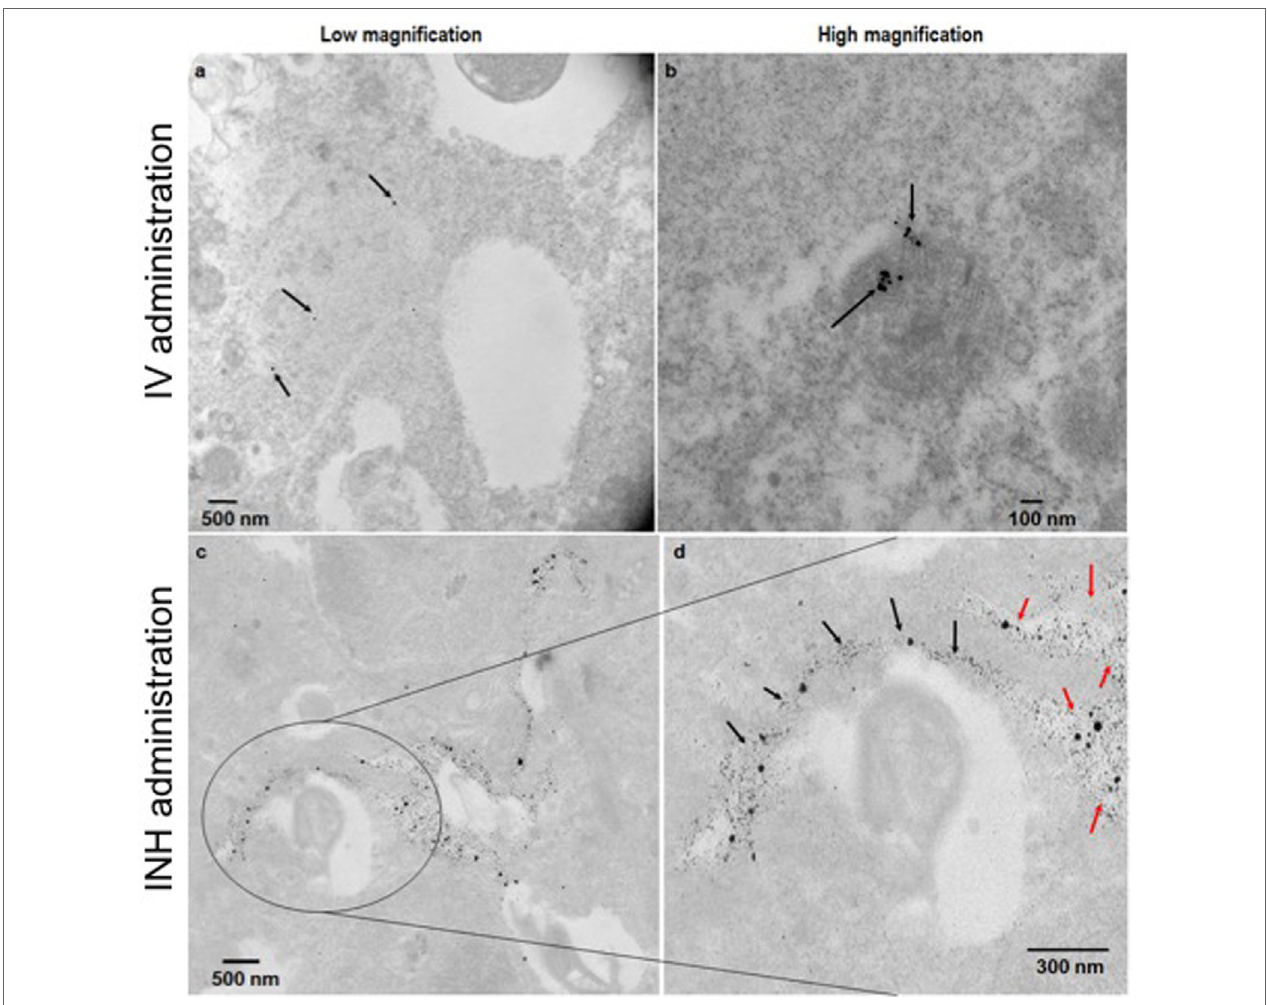
FiGUre 3 | TEM images of the lung tumor sections with nanoparticles drones administered intravenously (A,B) or via inhalation (INH) route (c,D) . Panel (D) is a magnified area of the image in panel (c) to show the nanoparticles drones that have migrated from the air spaces (red arrows) to the tumor tissue (black